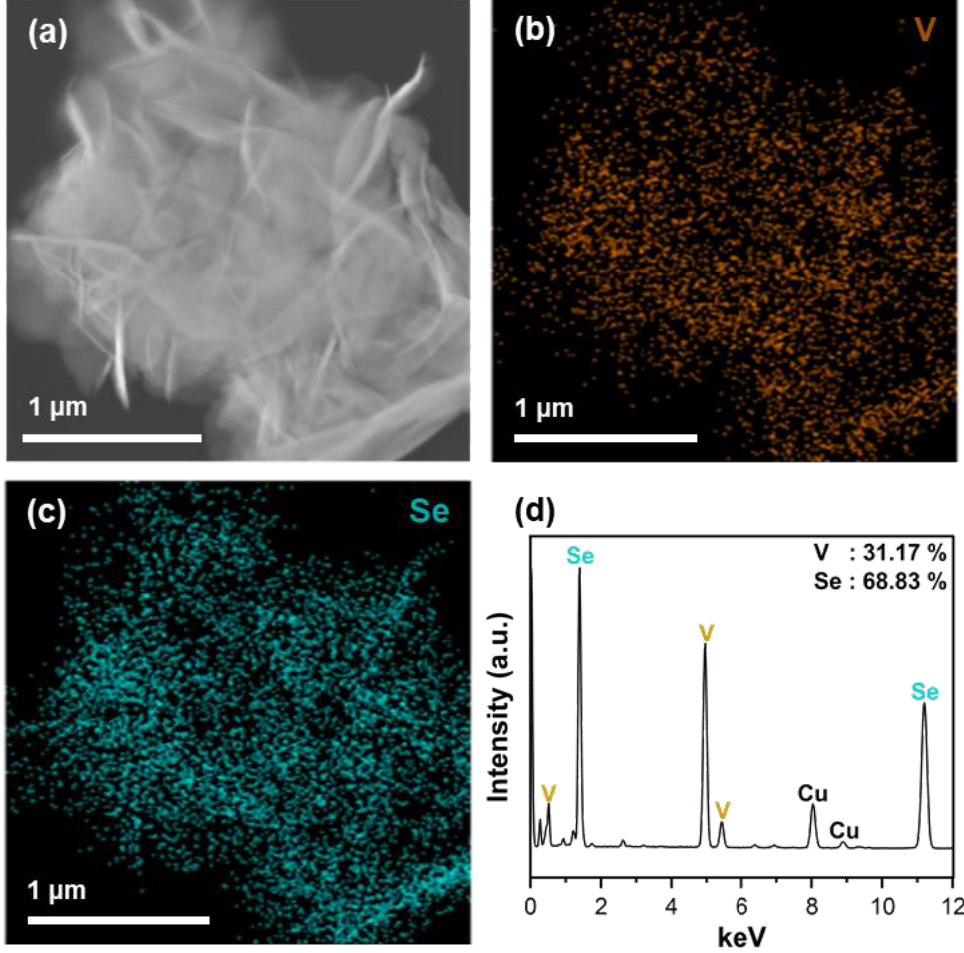
Figure 2. ( a ) TEM image of VSe 2 . Elemental mapping image of ( b ) vanadium, ( c ) selenium. ( d ) EDS spectrum.